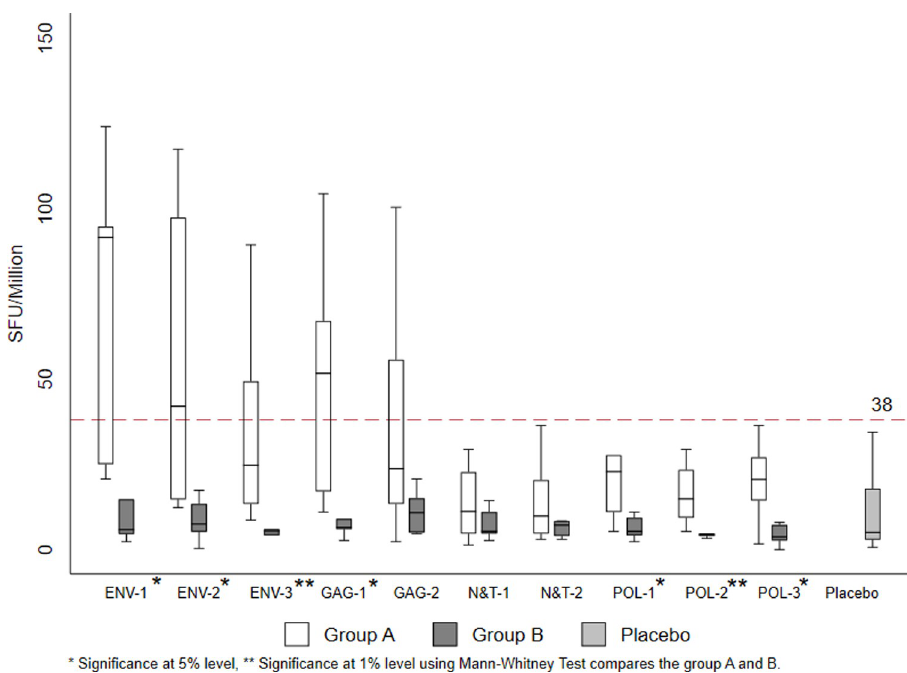
Fig 2. Frequency of positive IFN- γ ELISPOT responses. Magnitude of IFN- γ ELISPOT response (SFC/106 PBMC) and responder rate (%)at one week post last vaccination to Env, Gag, Pol and Nef /Tat peptides (group A: after 2 doses of DNA and 2 dose of MVA; group B after 3 doses of MVA; placebo results are from groups A and B combined).